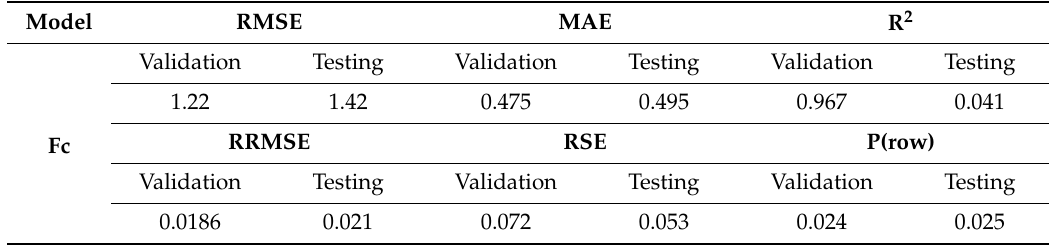
Table 7. Random forest (RF) statistical